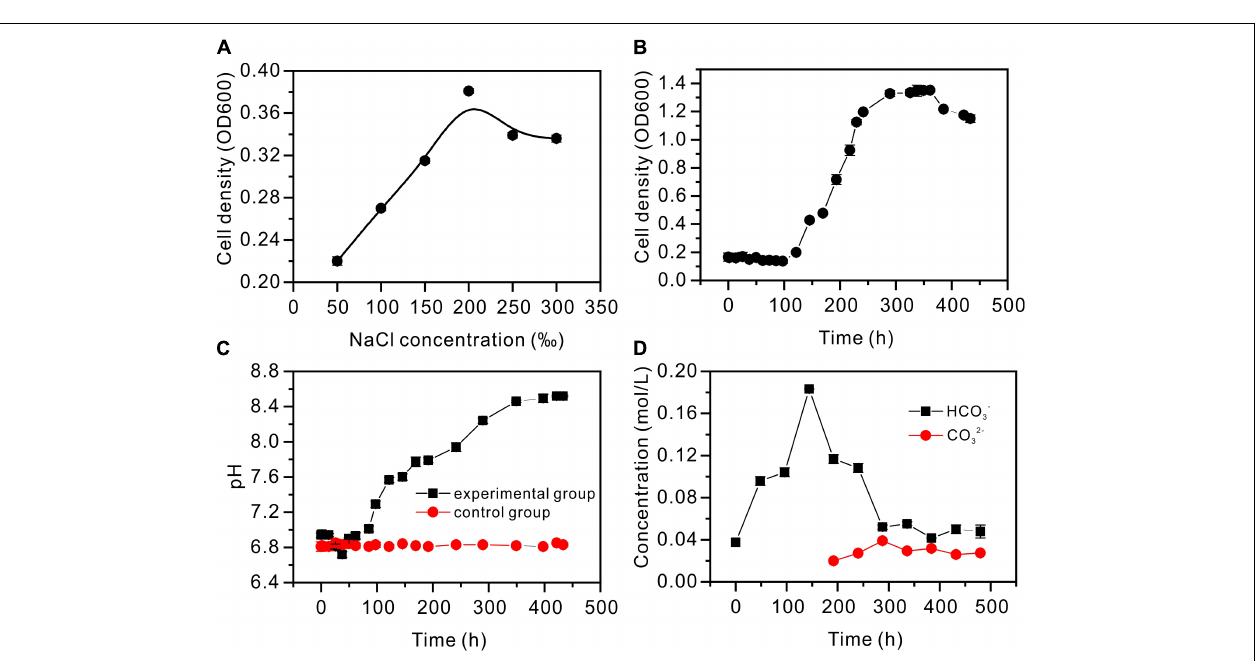
FIGURE 2 | Phylogenetic tree of Vibrio harveyi QPL2 and its closest relatives based on the 16S rDNA sequence, which was constructed by the neighbor-joining method.